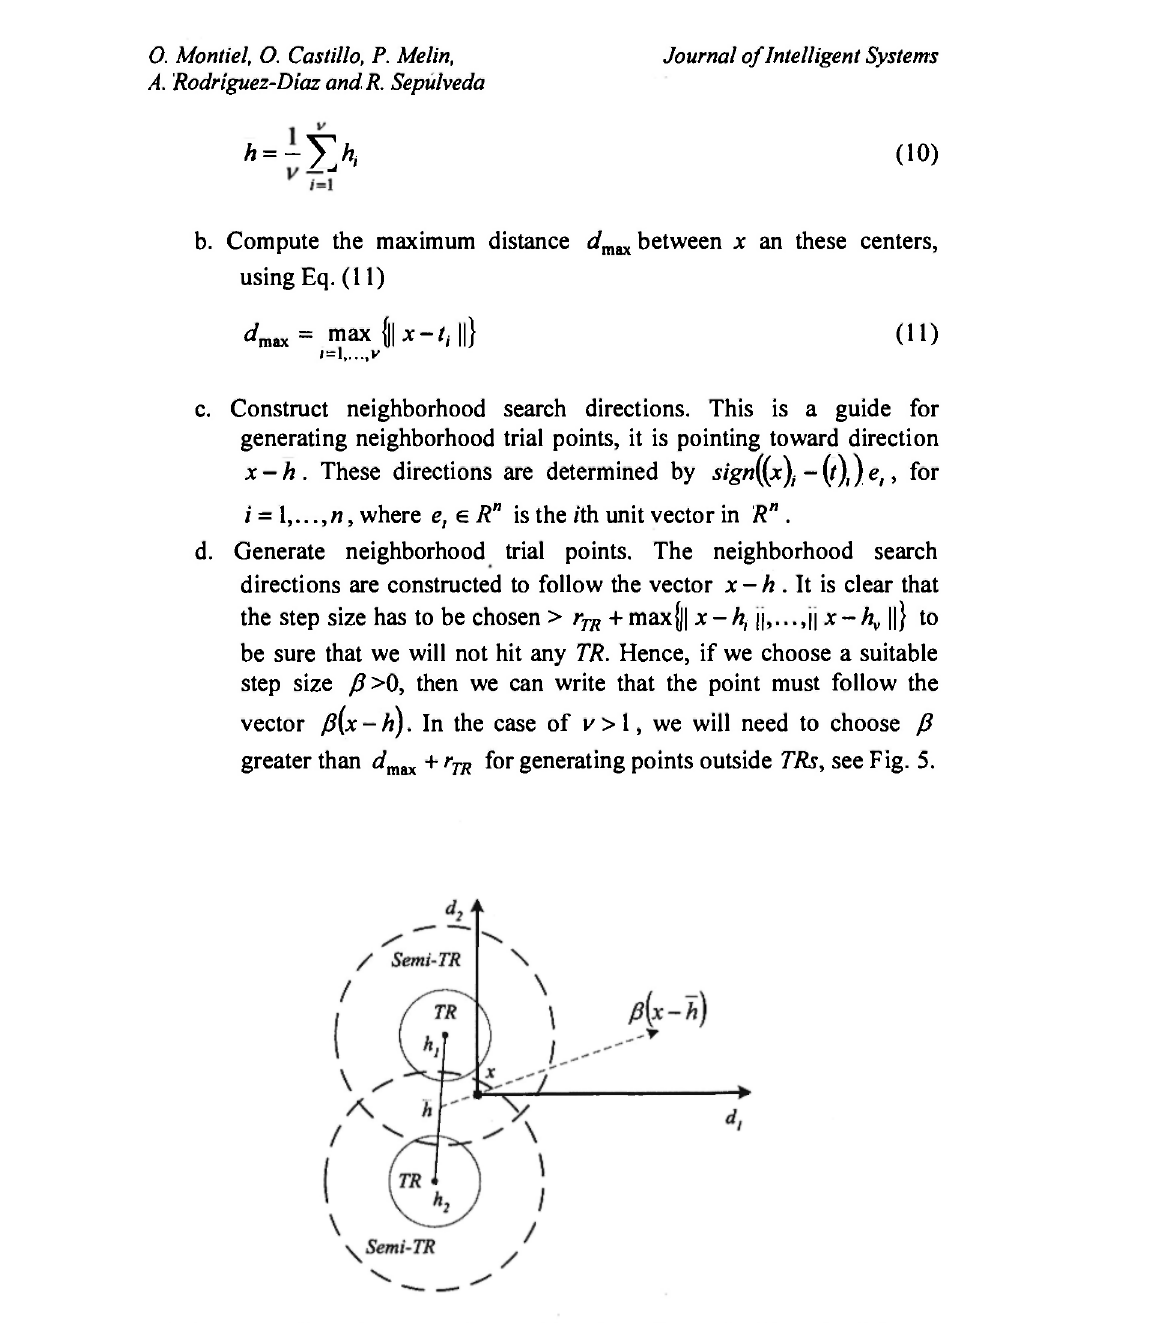
Fig. 5: Two dimensions example. A trial point χ lie in Semi-TRs is giving us directions for performing neighborhood searching must be enough big to generate points outside TRs (Onelife,